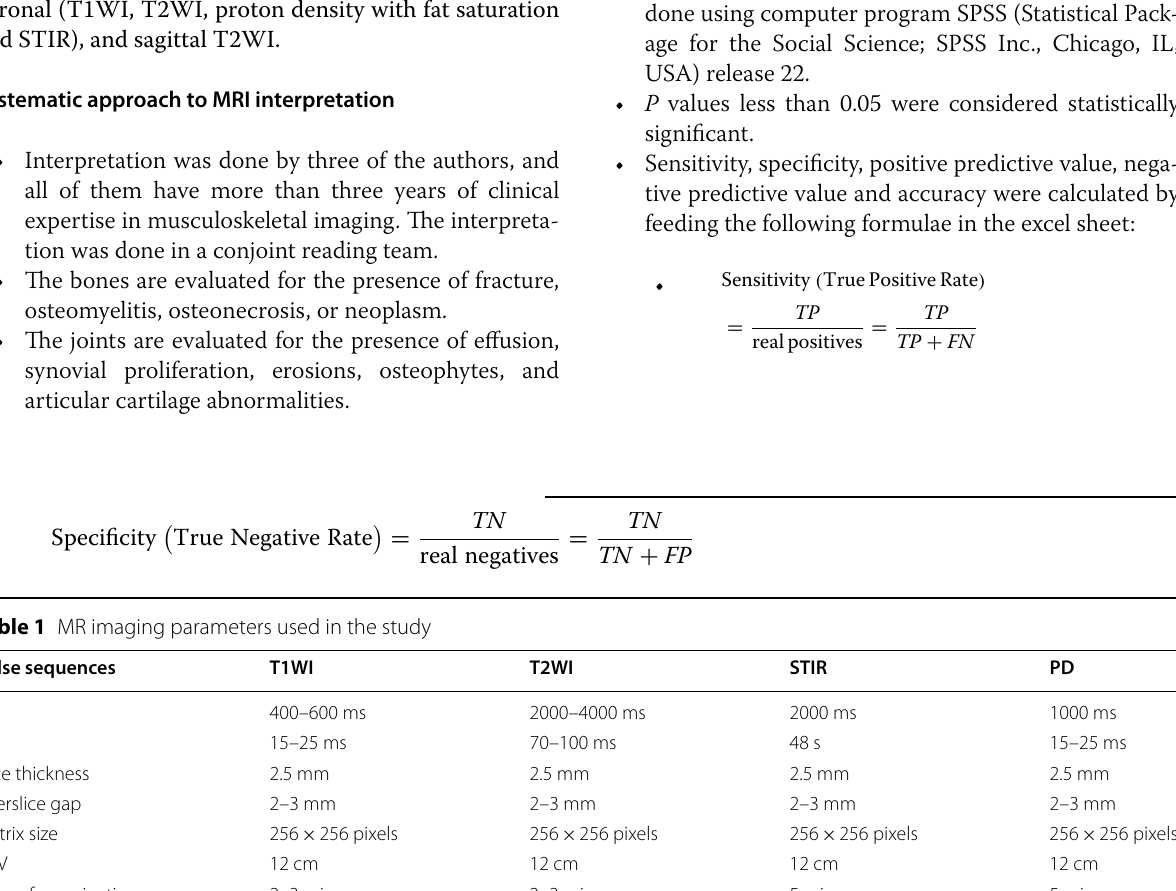
Protocol of MR imaging The imaging protocol and its parameters (Table 1) consisted of a scout three planes: T1-weighted images (T1WI), axial (T1WI and T2WI), coronal (T1WI, T2WI, proton density with fat saturation and STIR), and sagittal T2WI.